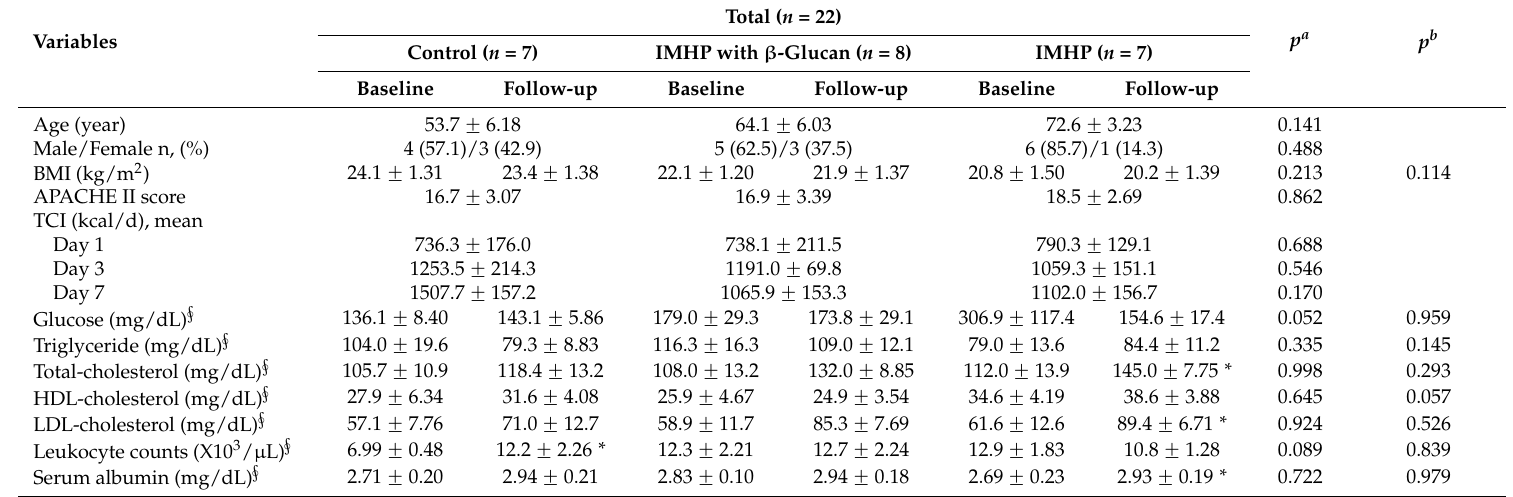
Table 2. Clinical characteristics in the control and in IMHP groups with and without β